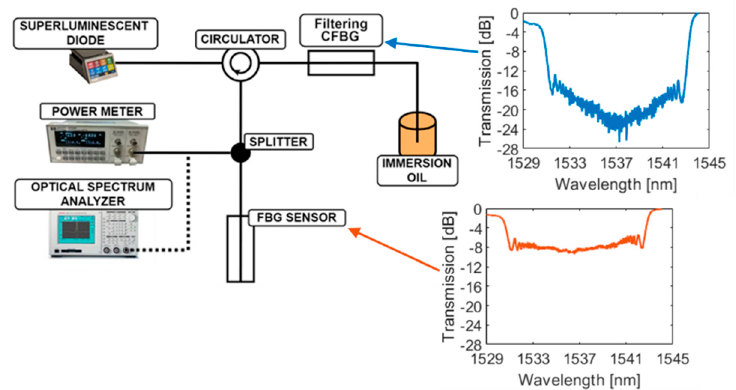
Figure 6. Experimental measurement setup of the abrasion sensor. Connections are made with SMF-28 optic fiber. Inset graphs show transmission spectra for both sensor and filtering grating.